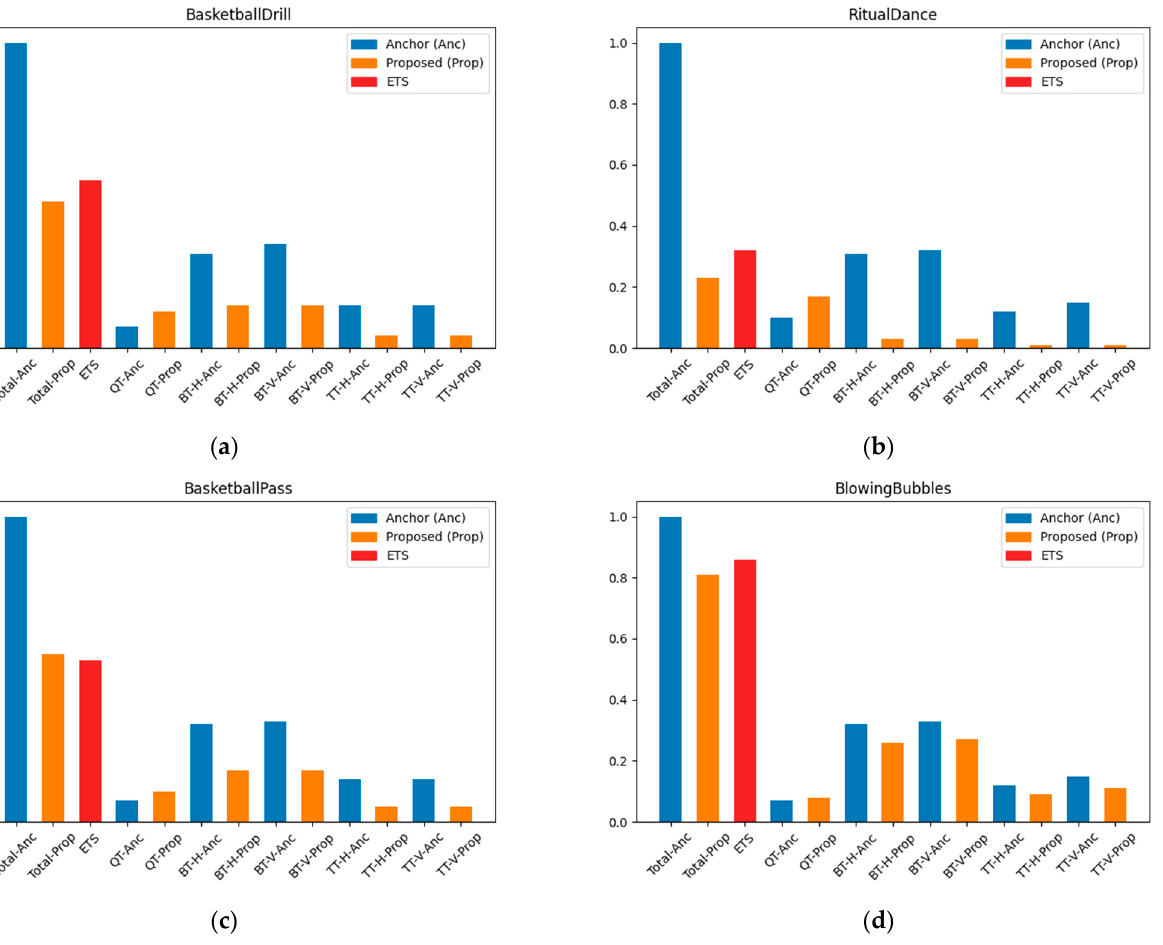
Figure 12. Comparisons of the block check reduction rate and ETS of the proposed method: ( a ) Bas- ketballDrill ; ( b ) RitualDance ; ( c ) BasketballPass ; ( d ) BlowingBubbles .